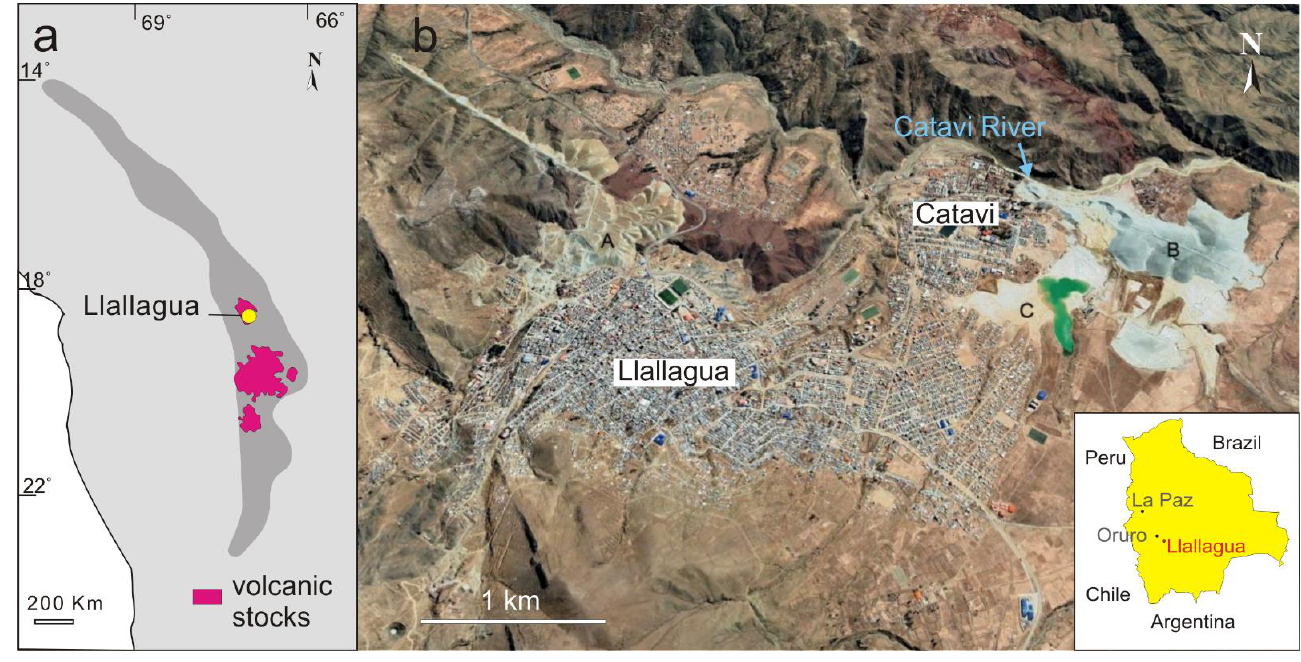
Figure 1. ( a ) Location of Llallagua in the Central Andean tin belt. Data from [27]; ( b ) View of Llal- lagua city and the mining wastes: A, dumps; B, sand tailings; and C, fine